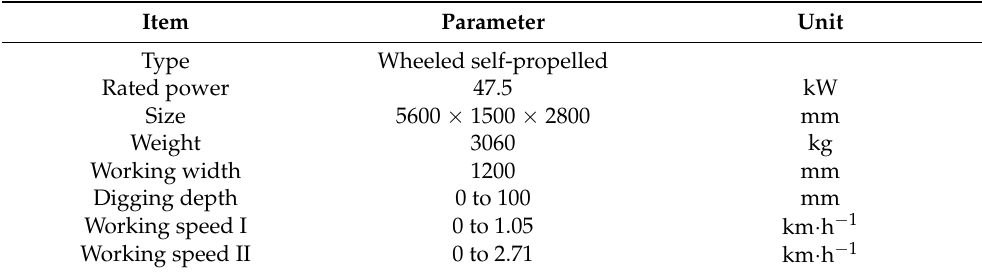
Figure 2. Block diagram of working principle of garlic combine harvester of cut–dig type under 4DS-1200 model.